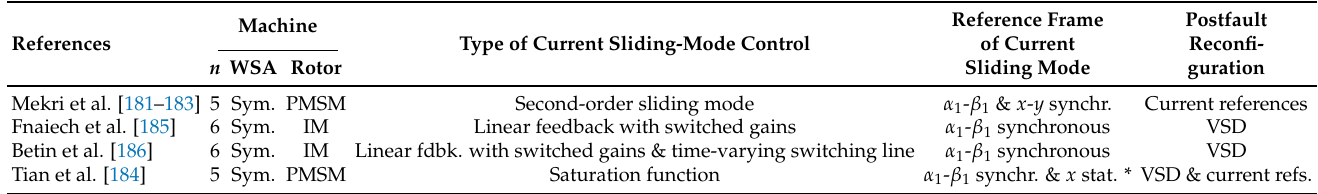
Table 10. Methods based on RFOC with current sliding-mode control for tolerating phase OCs (Section 3.4.5) in multiphase applications in the